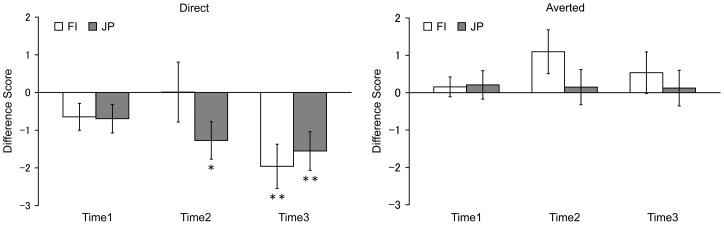
Heart rate difference scores in the computer-controlled stimulus presentation block.The mean heart rate difference scores of direct gaze (left) and averted gaze (right) in the computer-controlled stimulus presentation block in the FI group (white bars) and the JP group (grey bars). The following abbreviations are used: FI, Finnish; JP, Japanese; **p<.01, *p<.05; Asterisks below error bars indicate significant difference from zero. Error bars represent standard errors.